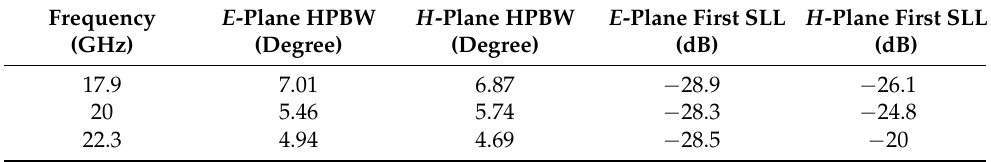
Table 2. Radiation characteristics of the proposed